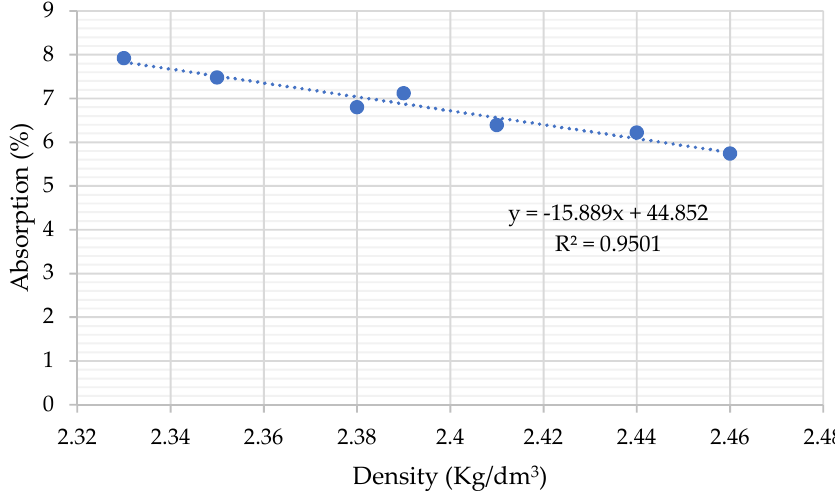
Figure 7. Relationship between density and absorption. Table 8. Penetration of water under pressure